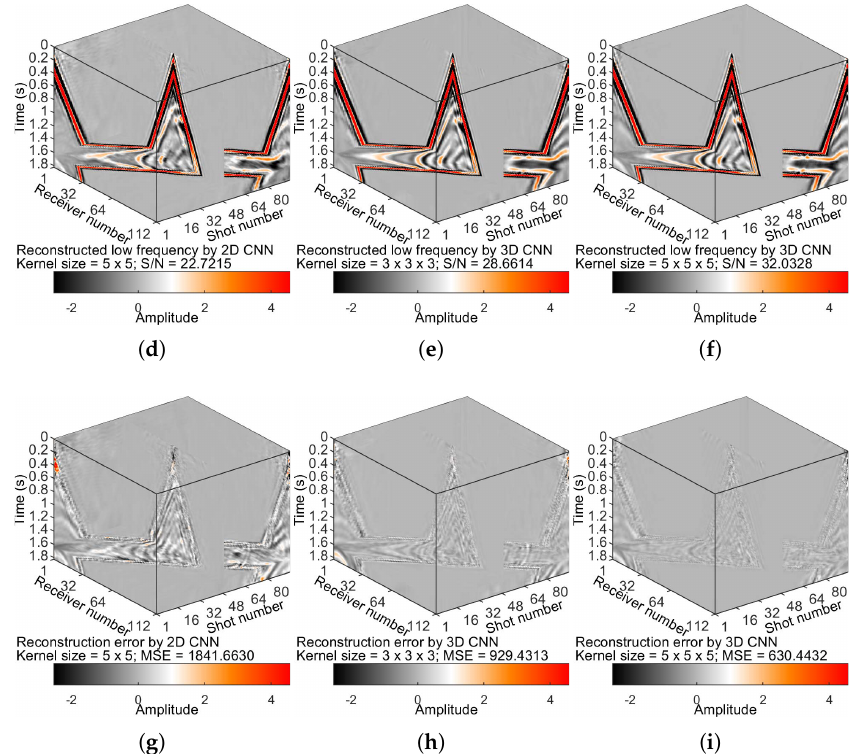
Figure 11. LFR on the Marmousi [39] synthetic dataset generated by PySIT [31]. ( a ) Simulated shot gathers. ( b ) HF data ( (cid:62) 5 Hz) of ( a ). ( c ) True LF data ( < 5 Hz) of ( a ). Panel ( d ) shows the predicted LF data by 2D CNN with a convolutional kernel size of 5 × 5. Panels ( e , f ) show the predicted LF data by 3D CNN with convolutional kernel sizes of 3 × 3 × 3 and 5 × 5 × 5, respectively. Panels ( g – i ) show the LFR residuals for the results in panels ( d – f ), respectively. For how we plot these cubes (and those in Figures 4, 5, 7 and 9), we use the slice function in MATLAB. slice(X, Y, Z, V, Sx, Sy, Sz) draws slices along the x-, y-, and z-directions at the points in the vectors Sx, Sy, and Sz. The arrays X, Y, and Z define the coordinates for V. The sharp truncations in the middle, e.g., in panel ( a ), are not because of the short recording time.